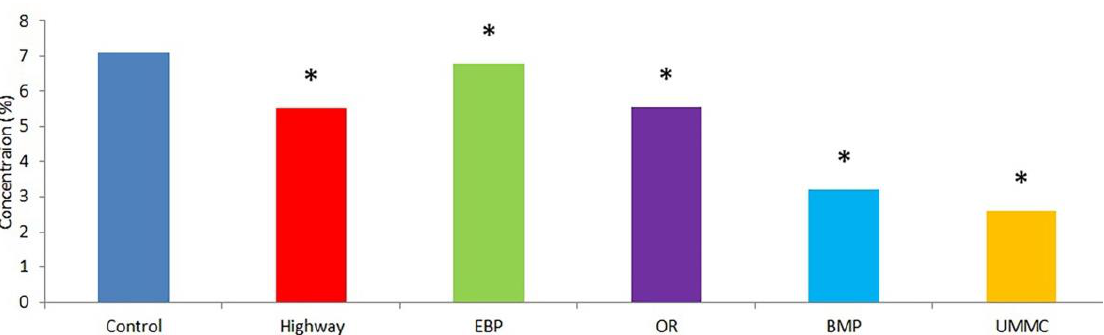
Figure 7. Plant phenolics concentration in coltsfoot from studied areas. *—statistically significant difference between control and test group ( p ≤ 0.05).